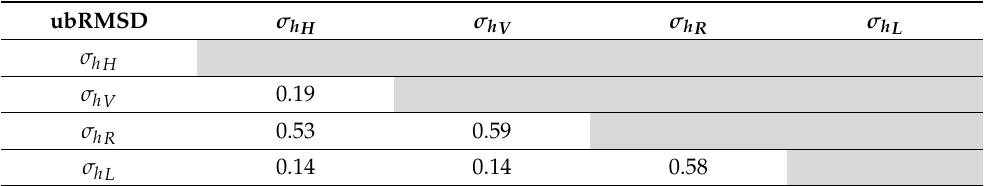
Table 2. The ubRMSD between PO modeled rms height ( σ h ) at different polarizations. Units are in centimeters. ubRMSD